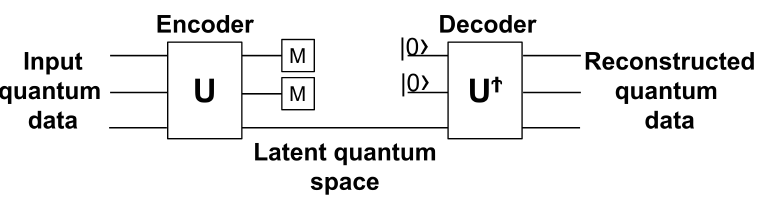
Figure 3. Schematic representation of a quantum autoencoder. The encoder acts as a unitary transfor- mation U that tries to disentangle a certain number of qubits (force them to the | 0 (cid:105) state). In this way, the initial quantum information is compressed into a latent quantum space. The decoder implements the inverse transformation U † to reconstruct the original data. The loss function is taken as the measurement expectation value of the qubits that are eliminated after the compression.